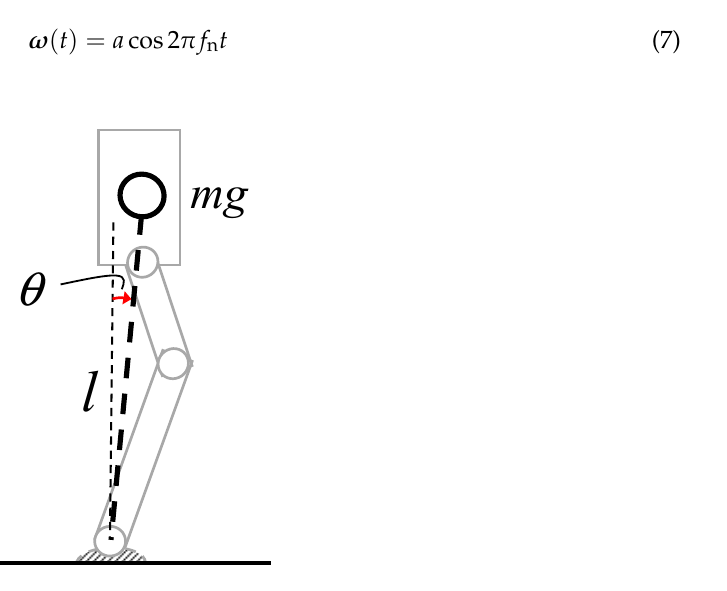
Figure 15. The inverted pendulum model (IPM) to explain the robot walking dynamics. The parameters θ , m , l, and g are the angle of robot-torso rotation in the sagittal plane, robot mass, robot-center-of-mass distance from the ankle-pitch motor, and acceleration due to gravity, respectively. Table 1. KONDO KHR-3HV robot physical